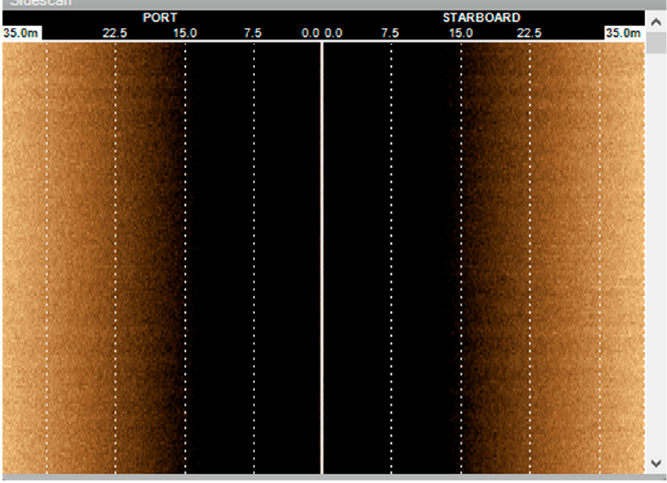
Figure 10. Electrical isolation with cables separated.